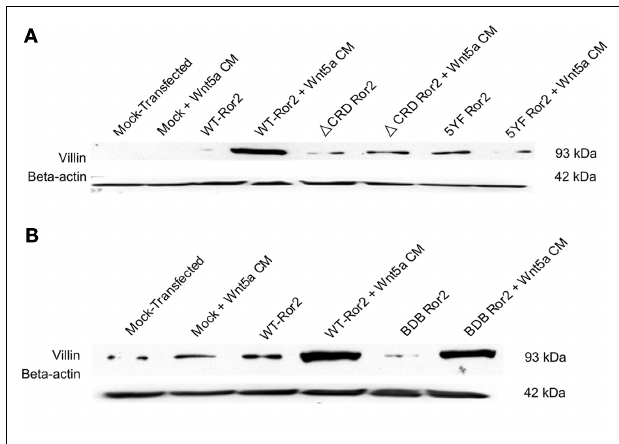
FIGURE 5 |Wnt5a-challenge attenuated villin protein expression in cells transfected with Δ CRD Ror2 and 5YF Ror2, but villin expression was increased in BDB Ror2-expressing cells. (A) Wnt5a challenge induced a noticeable upregulation in villin protein expression in Ror2-overexpressing HT29 cells, as previously observed. In similarly challenged cells transfected with a Δ CRD Ror2 construct, where the cysteine-rich domain of the receptor has been deleted, or with 5YF Ror2, a plasmid construct where five tyrosines of the Ser/Thr-1 region had been substituted with phenylalanines, villin protein expression was not increased.These low levels of villin expression resembled those found in mock-transfected and/or untreated control cells. β -actin immunoblotting was completed to show equal loading. Blots were representative of three separately performed experiments. (B) In HT29 cells transfected with BDB Ror2, which is characterized by a deletion of the proline and serine/threonine-rich domains of the receptor, levels of villin protein expression were increased uponWnt5a CM challenge.This increased villin expression was comparable to that observed in similarly challengedWT Ror2-transfected cells.These results represent three individually performed experiments with similar results.Western blotting for β -actin was included as a loading control.